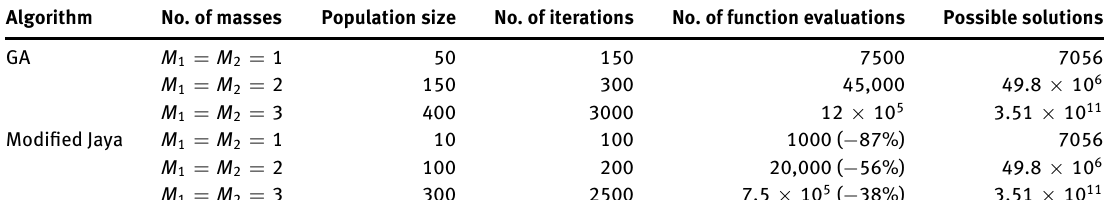
Table 6: Comparison of Performance of the Modified Jaya Algorithm with a GA Algorithm [27]. Algorithm